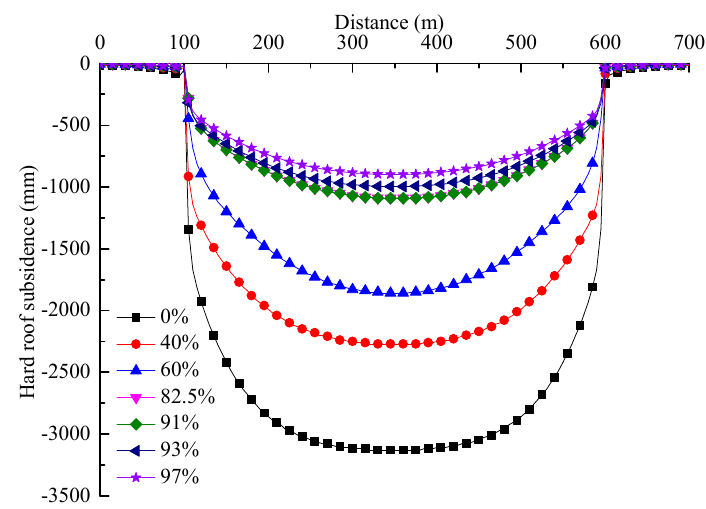
Figure 7. Maximum subsidence of the hard roof for different roof-controlled backfill ratios.